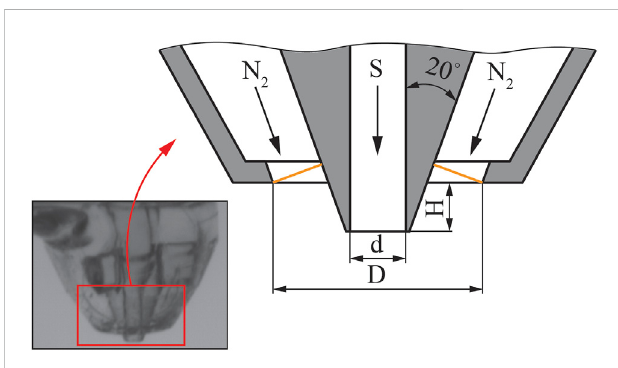
FIGURE 2 Design of the GDVN for fl ow focusing in an electric fi eld. D = 150 μ m, d = 40 μ m and H = 35 μ m. The orange lines show the cross section of the area that gas fl ows, used to de fi ne the Reynolds number.